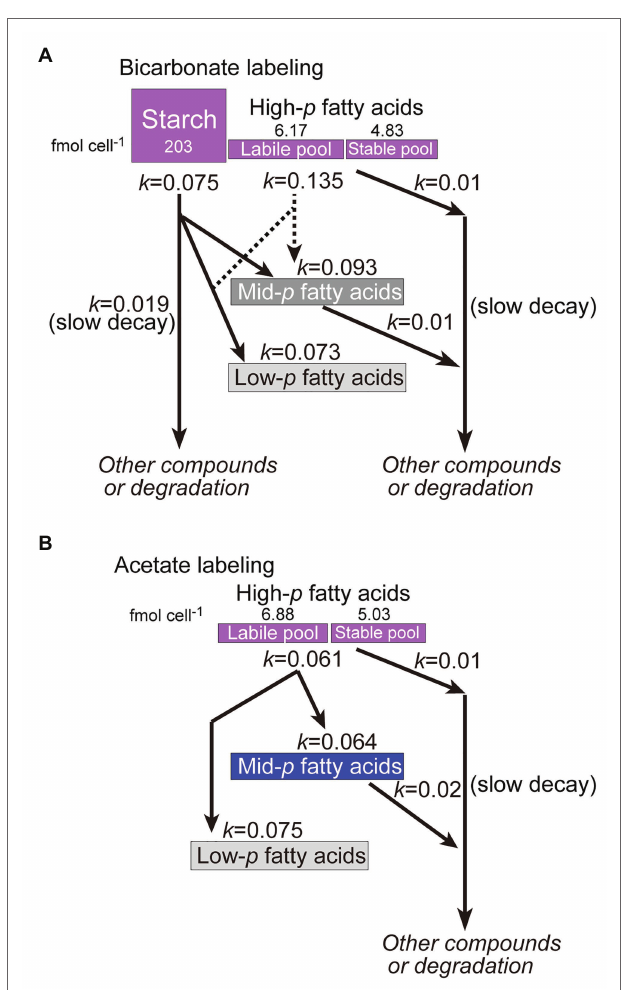
FIGURE 10 | Model of labeling and remodeling of starch and fatty acids as deduced from the labeling and chase experiments. (A) Bicarbonate labeling; (B) Acetate